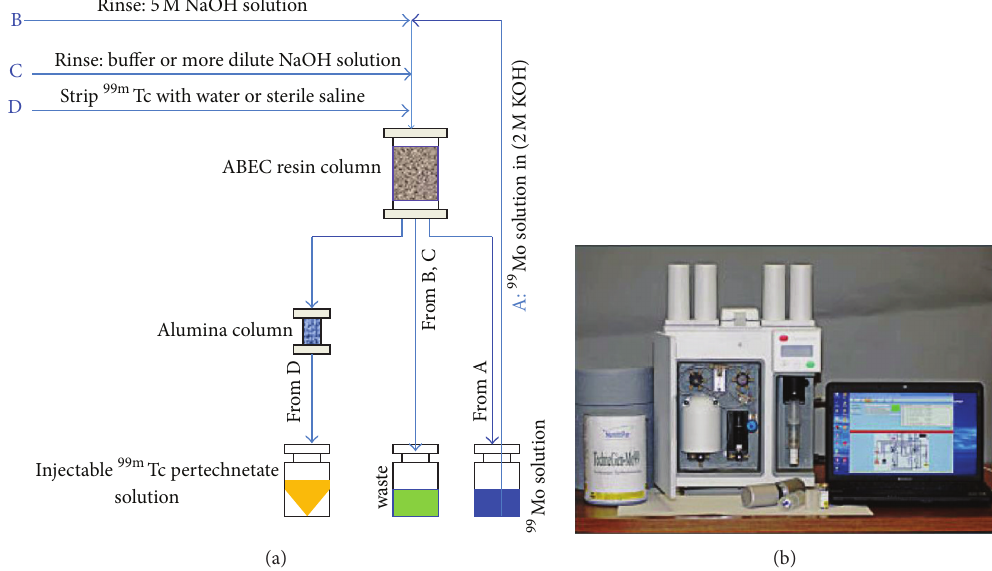
Figure6: 99 m TcrecoveryusingABECresincolumn:(a)processdiagram;(b)automatedradionuclideseparatorARSIIdevelopedbyNorthStar Medical Radioisotopes (USA) using ABEC resin column [2].